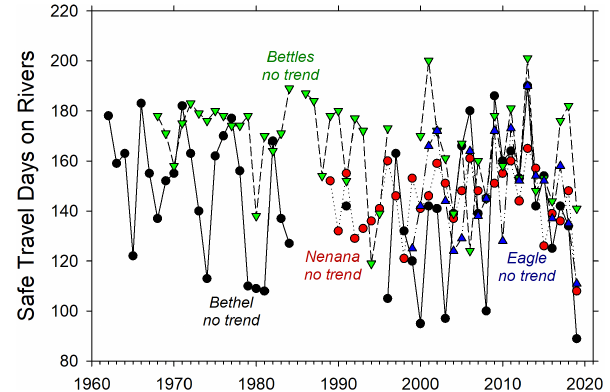
Figure 8. Ice travel duration on rivers estimated from ice growth curves for each period of